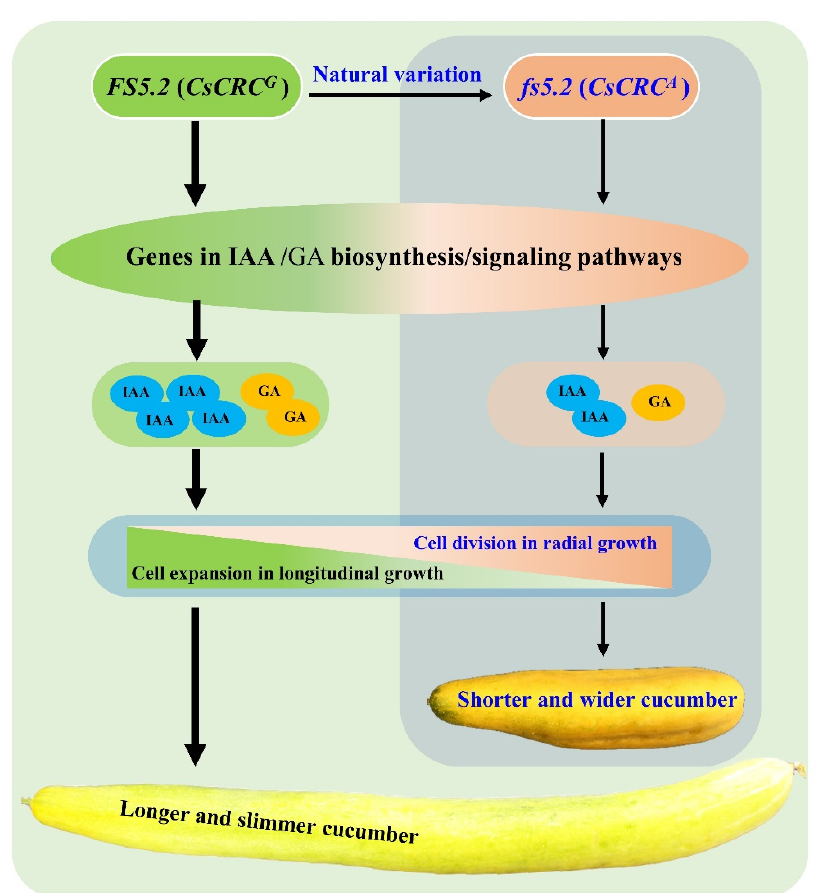
Figure 7. A working model depicting roles of FS5.2 ( CsCRC ) in regulating cucumber fruit shape/size formation. A nonsynonymous SNP ( G to A ) in CsCRC might cause the changes in cucumber fruit shape/size from long and slim fruit in WI7237 ( FS5.2 , CsCRC G ) to shorter and wider fruit in fs5.2- WI7237 ( fs5.2 , CsCRC A ). CsCRC A mutation leads to lower contents of IAA and GA by regulating the expressions of genes involved in IAA and GA biosynthesis/signaling pathways, which promotes cell division (more cell layers) in radial fruit growth and inhibits cell expansion in longitudinal fruit growth, thus forming a shorter and wider fruit. Conversely, CsCRC G regulates the formation of longer and slimmer fruits in cucumber.